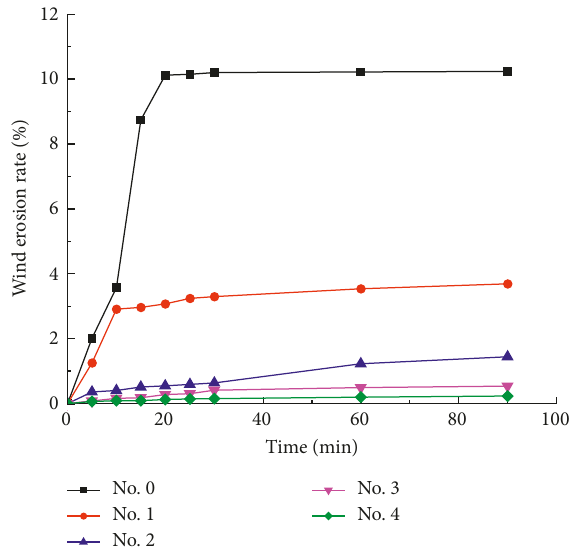
Figure 7: Wind erosion rate of MICP-treated sand.